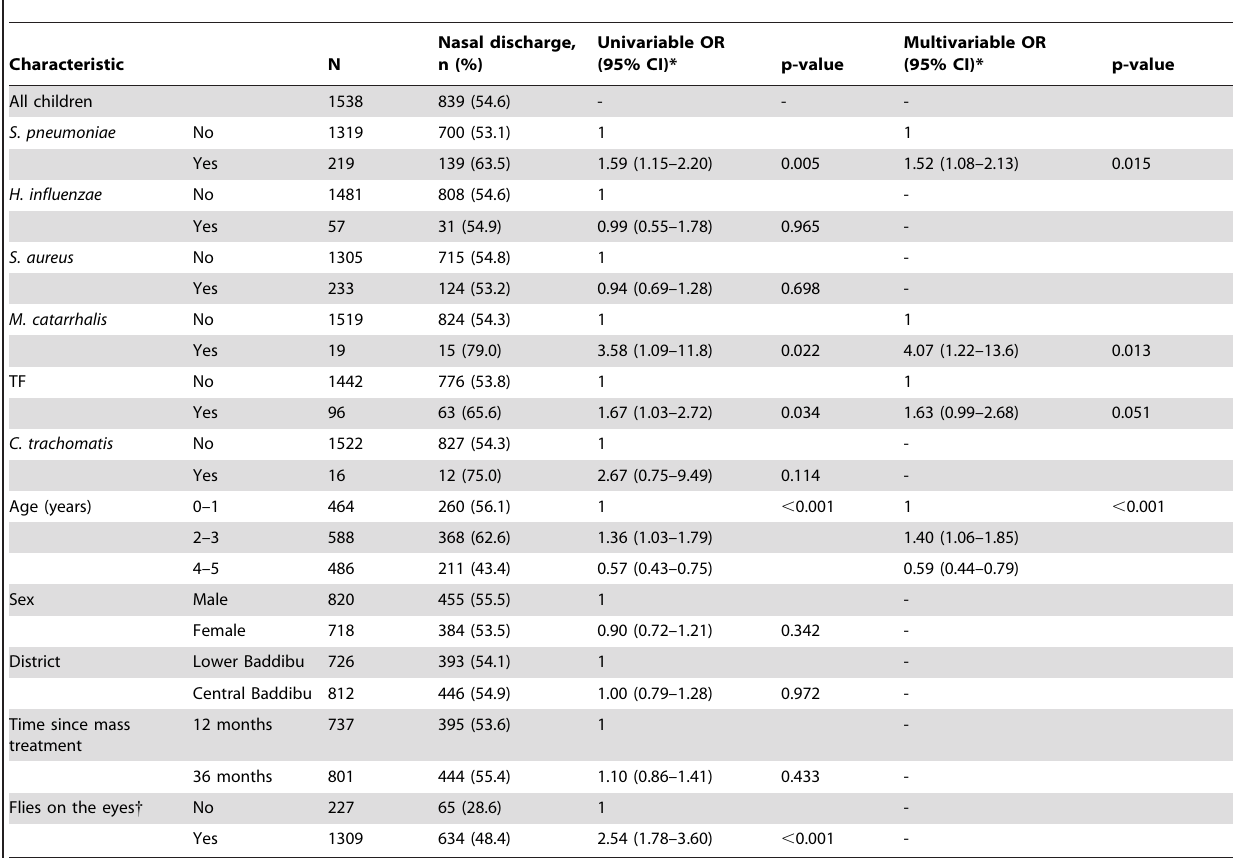
Table 3. Associations with nasal discharge in 0–5 year olds.